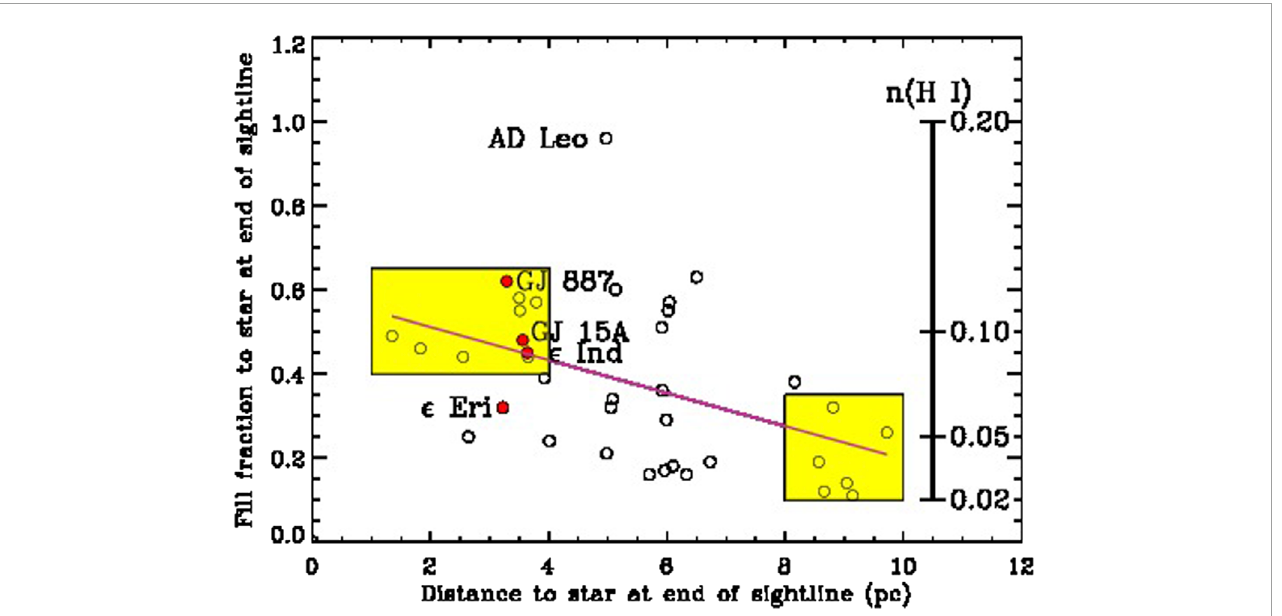
FIGURE 2 Plot of the filling fraction of neutral hydrogen clouds along sight lines to stars vs. stellar distance. On the right side is the scale of neutral hydrogen density if the sight lines are completely filled with clouds. The left colored box identifies sight lines that would be filled by clouds with a mean density n (H I) ≈ 0 . 10 cm −3 . The right colored box identifies sight lines with distant clouds that are widely separated. The 4 stars within 4 pc of the Sun with only LIC and astrospheric absorption are identified in the figure. Figure from Linsky and Redfield,